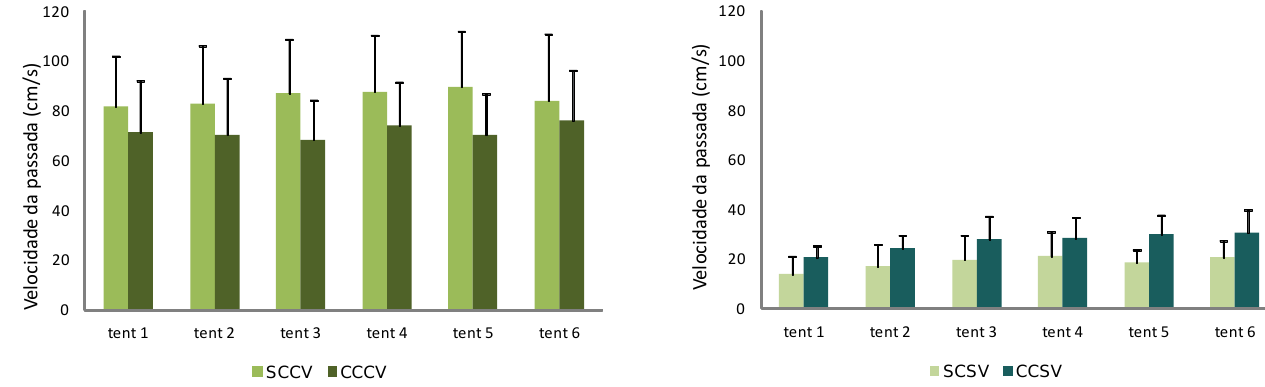
Figura 6. Média e desvio-padrão da velocidade das passadas nas condições experimentais com e sem o cão, mas com uso da visão (lado esquerdo) e com e sem o cão, mas sem o uso da visão (lado